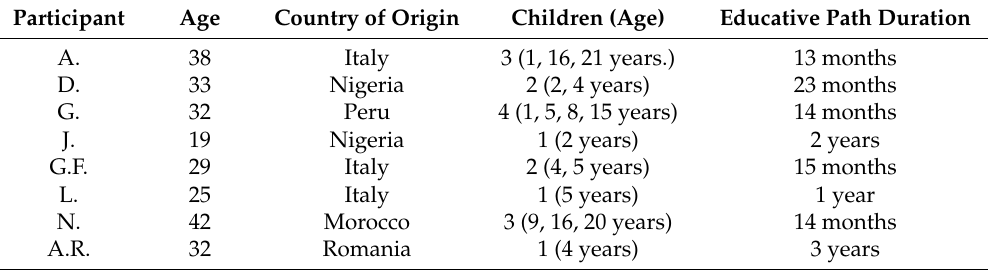
Table 1. Characteristics of the